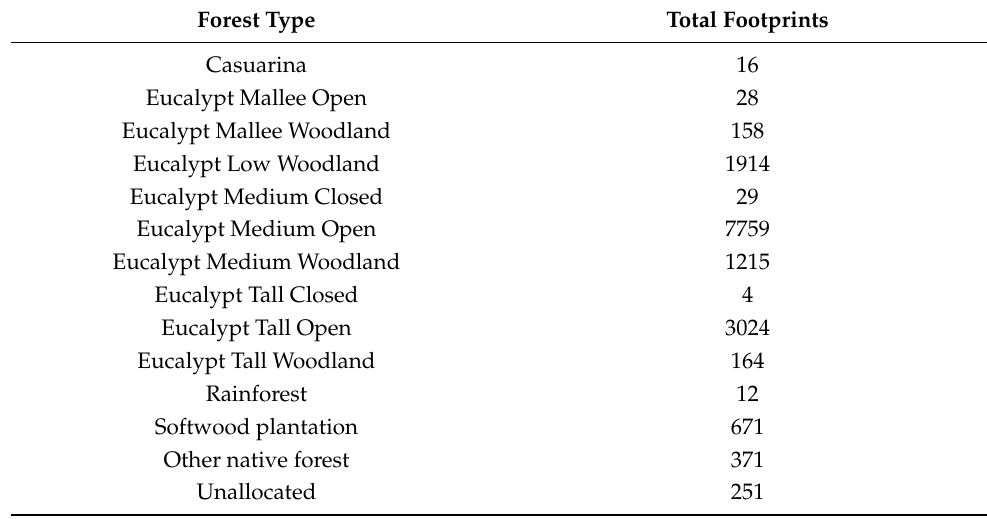
Table 1. Number of footprints per forest